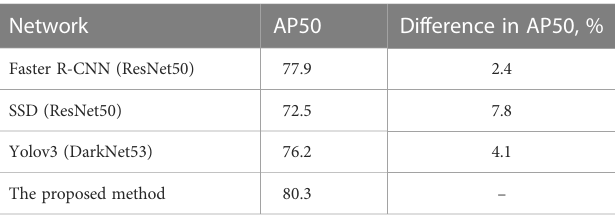
TABLE 3 Detection performance in different networks for the testing